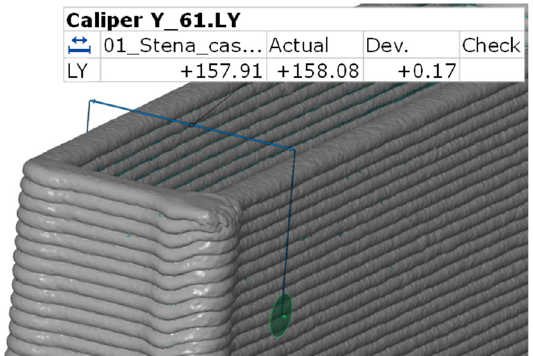
Figure 7. Local distance measurement with the “Caliper” function.